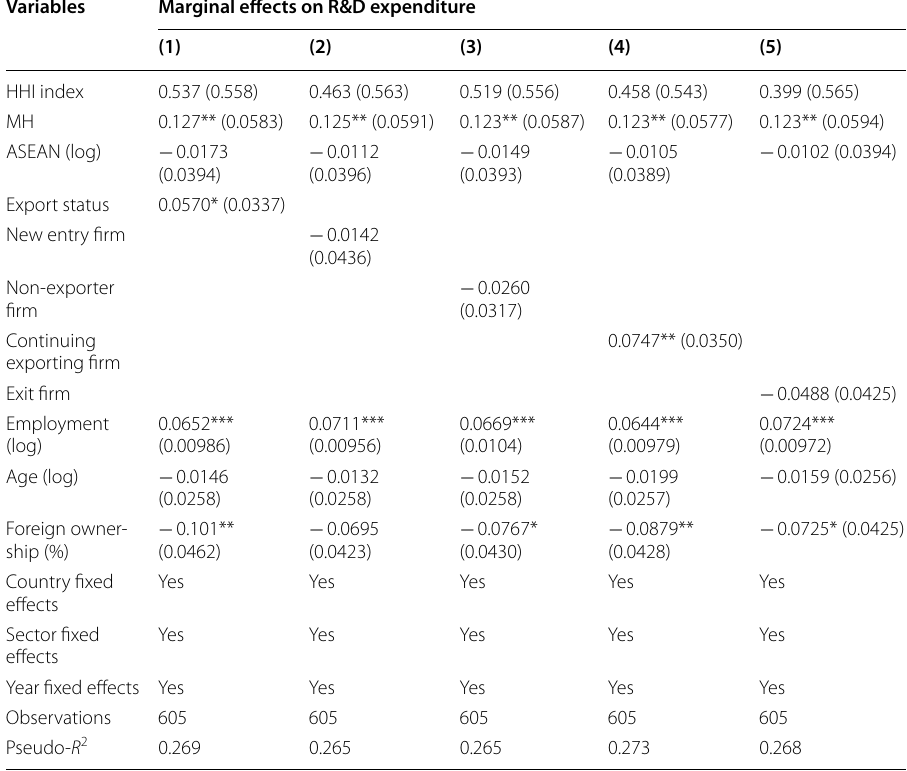
Table 3 R&D expenditure